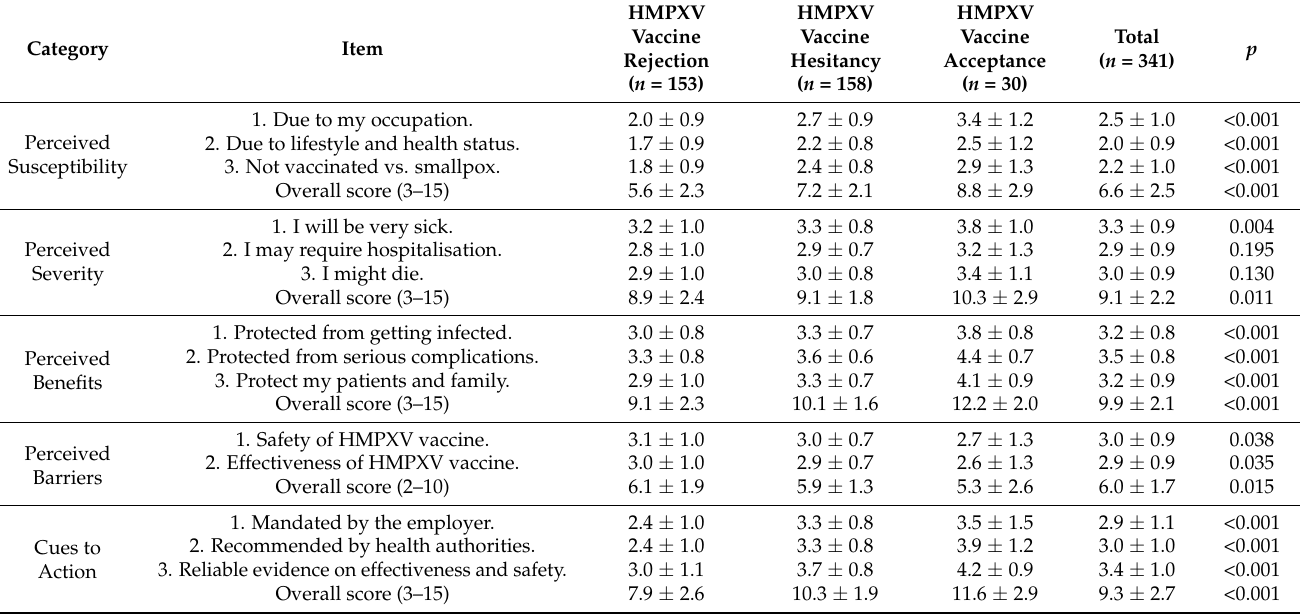
Table 6. HMPXV-vaccine-related perceptions of Czech HCWs responding to the HMPXV survey, September 2022 ( n =